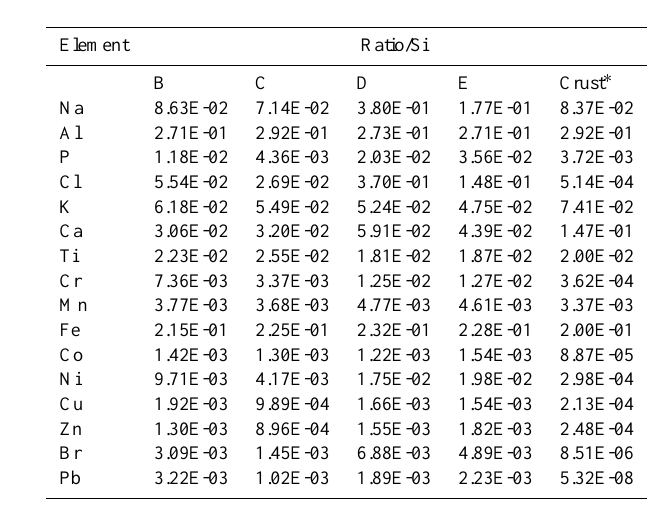
Table 3. Ratio of elements to